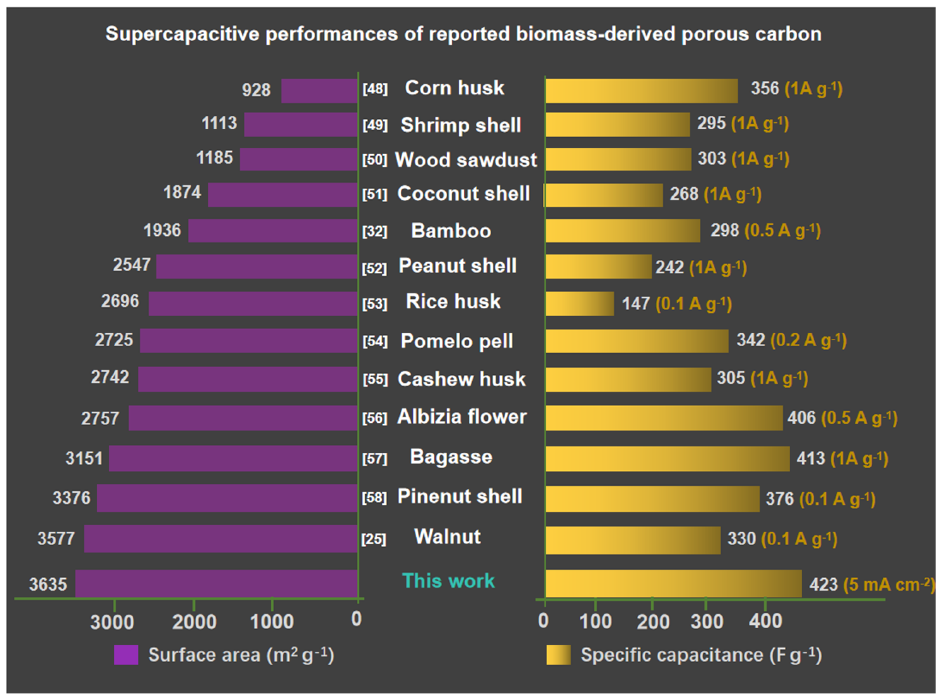
Figure 5. Comparison of the specific capacitance and surface areas of MJ-5 with the state-of-the-art biomass-derived carbon materials [48–58].